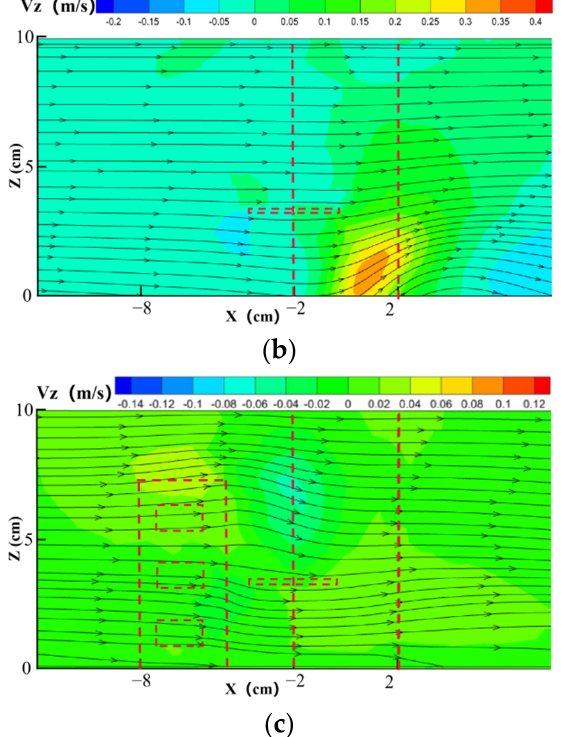
Figure 17. Streamlines and velocity contours at Y = − 2 cm. ( a ) Single pier; ( b ) Pier with ring-wing plate; ( c ) Pier with combined device.